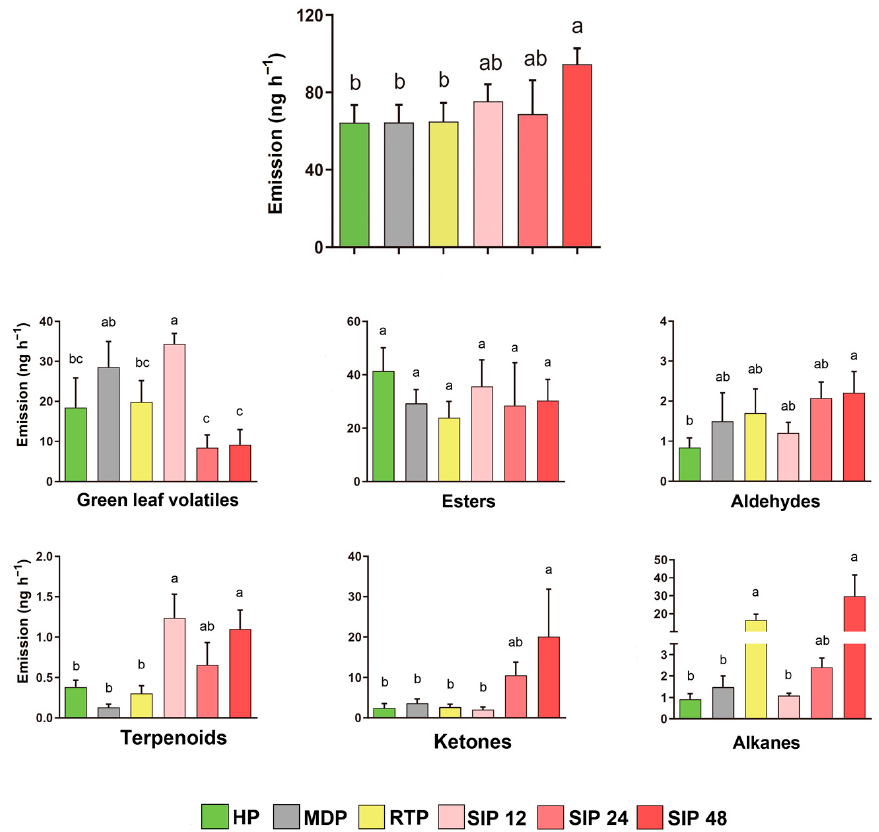
Figure 3. Total quantities of volatile organic compounds (VOCs) released by Chinese cabbage plants in response to six treatments. Total quantities of six classes of volatiles released by Chinese cabbage plants in response to six treatments. HP: healthy plants; MDP: mechanically damaged plants; RTP: regurgitate-treated plants; SIP: plants infested with S. litura for 12, 24, or 48 h. Values are means + SE. Bars labeled with different letters are significantly different by Tukey’s HSD test ( p < 0.05; one-way ANOVA, α = 0.05).